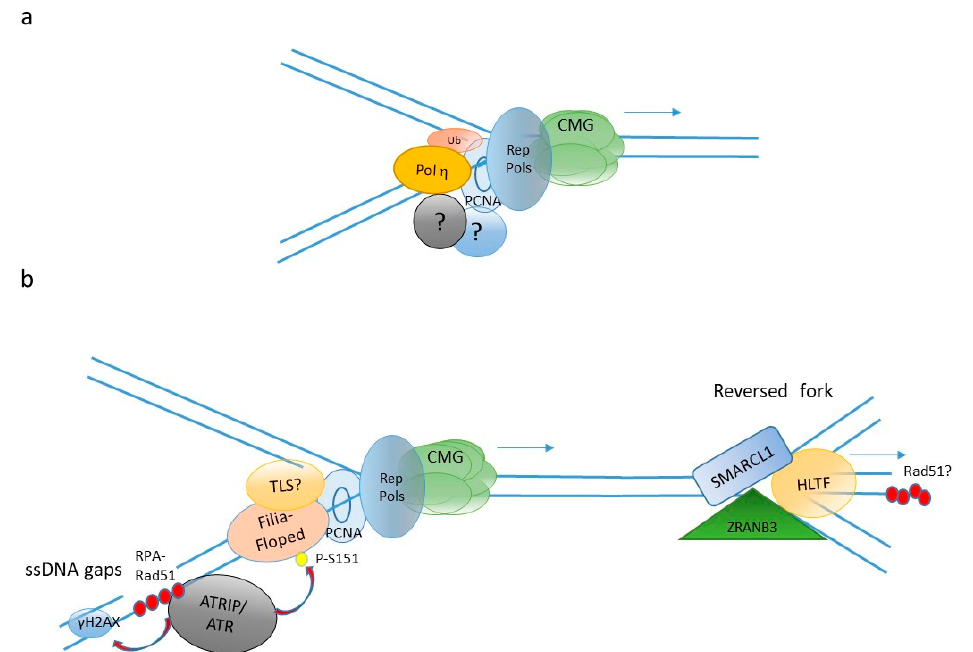
Figure 2. Embryonic DNA replication fork features. Schematic representation of DNA replication forks in ( a ) fast cleaving embryos and ( b ) mouse embryonic stem cells. Question marks indicate so far unidentified proteins including Y-family translesion synthesis (TLS) pols. Rep Pols indicates replicative DNA pols. Ub indicates ubiquitin. CMG indicates the replicative helicase. Arrows indicate the direction of translocation of the fork.